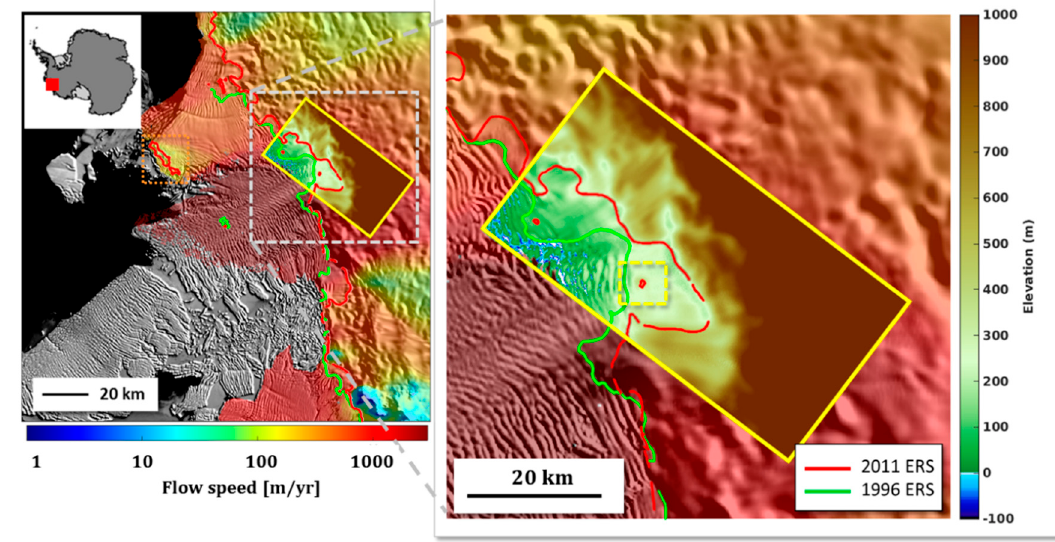
Figure 1. Grounding lines of Thwaites Glacier in 1996 (green) and 2011 (red) estimated using the DDInSAR method with European remote sensing (ERS) satellites [13,15]. The orange dotted rectangle in the eastern shelf indicates a larger ice rumple previously discussed by Tinto and Bell [7]. A newly-generated digital elevation model derived from TanDEM-X data on 10 June 2011 is shown within the yellow rectangle. The small red feature inside the yellow dotted square indicates the smaller ice rumple considered in this study. The background image is the MODIS Mosaic of Antarctica (MOA) image map [16]. The overlaid ice velocity map was extracted from Rignot et al.